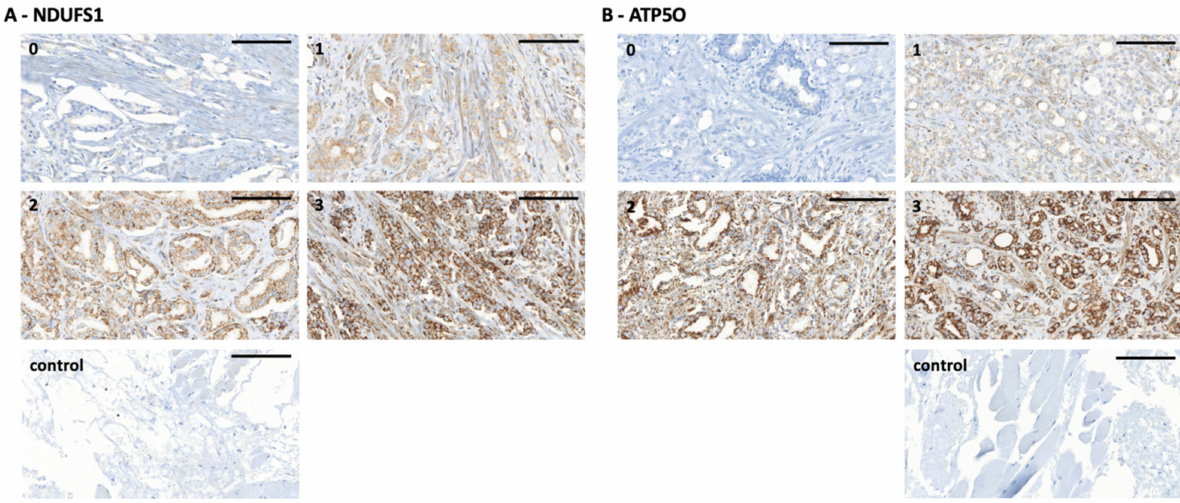
Figure 2. ( A ) NDUFS1 immunohistochemistry staining of PCa tissue microarray (TMA) samples. (0) staining intensity of 0 to 0.5, (1) staining intensity of 1, (2) staining intensity of 2, (3) staining intensity of 3, (control) technical negative control staining (left). Scale bar = 100 µ m. ( B ) ATP5O immunohistochemistry staining of PCa TMA samples. (0) staining intensity of 0 to 0.5, (1) staining intensity of 1, (2) staining intensity of 2, (3) staining intensity of 3, (control) technical negative control staining (right). Scale bar = 100 µ